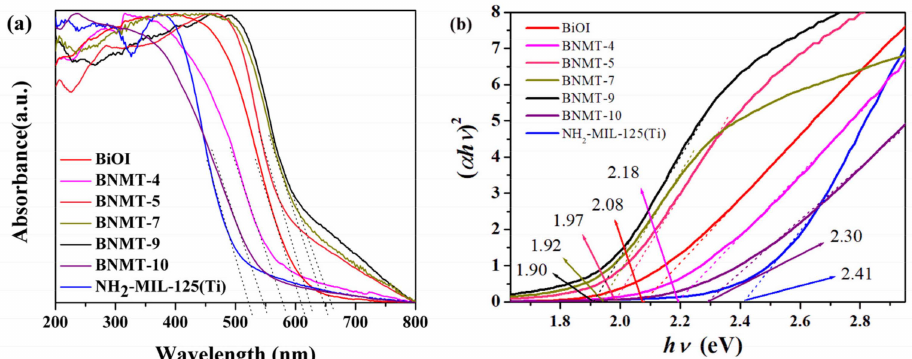
Figure 5. ( a ) Solid UV–vis diffuse reflectance spectra and ( b ) plots of ( α h v ) 2 versus (h v ) of BiOI, NH 2 -MIL-125(Ti), and BiOI/NH 2 -MIL-125(Ti) complexes in different